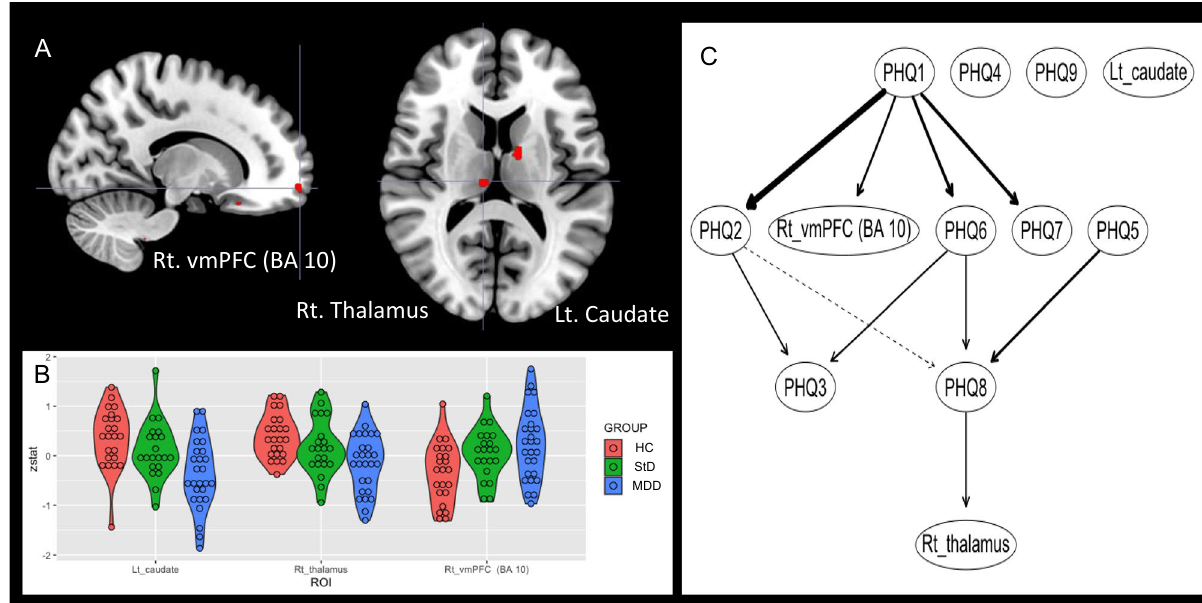
Figure 4. Between-group differences of functional brain activation for conflict control of incongruence trial against larger monetary loss, compared to the smaller monetary loss. Major depressive disorder (MDD) demonstrated higher functional activation of right ventromedial prefrontal cortex, and lower functional activation of left caudate and right thalamus compared to HC. ( A ) Clusters of brain functional activation with significant between-group differences (cluster-forming thresholds of P < 0.001 and k ≥ 10). ( B ) Violin plots of z-stats per clusters per group. ( C ) Directed acyclic graph that represents conditional independence associations among depressive symptoms [9 items of Patient-Health Questionnaire-9 (PHQ-9)] and z-stats of 3 brain clusters. Directional associations from sadness and concentration difficulty to functional activation of ventromedial prefrontal cortex and thalamus were found. PHQ-1 sadness, PHQ2 anhedonia, PHQ3 sleep disturbance, PHQ4 appetite change, PHQ5 psychomotor change, PHQ6 fatigue, PHQ7 self-reproach, PHQ8 concentration difficulty, PHQ9 suicidal ideation, Lt left, BA Brodmann